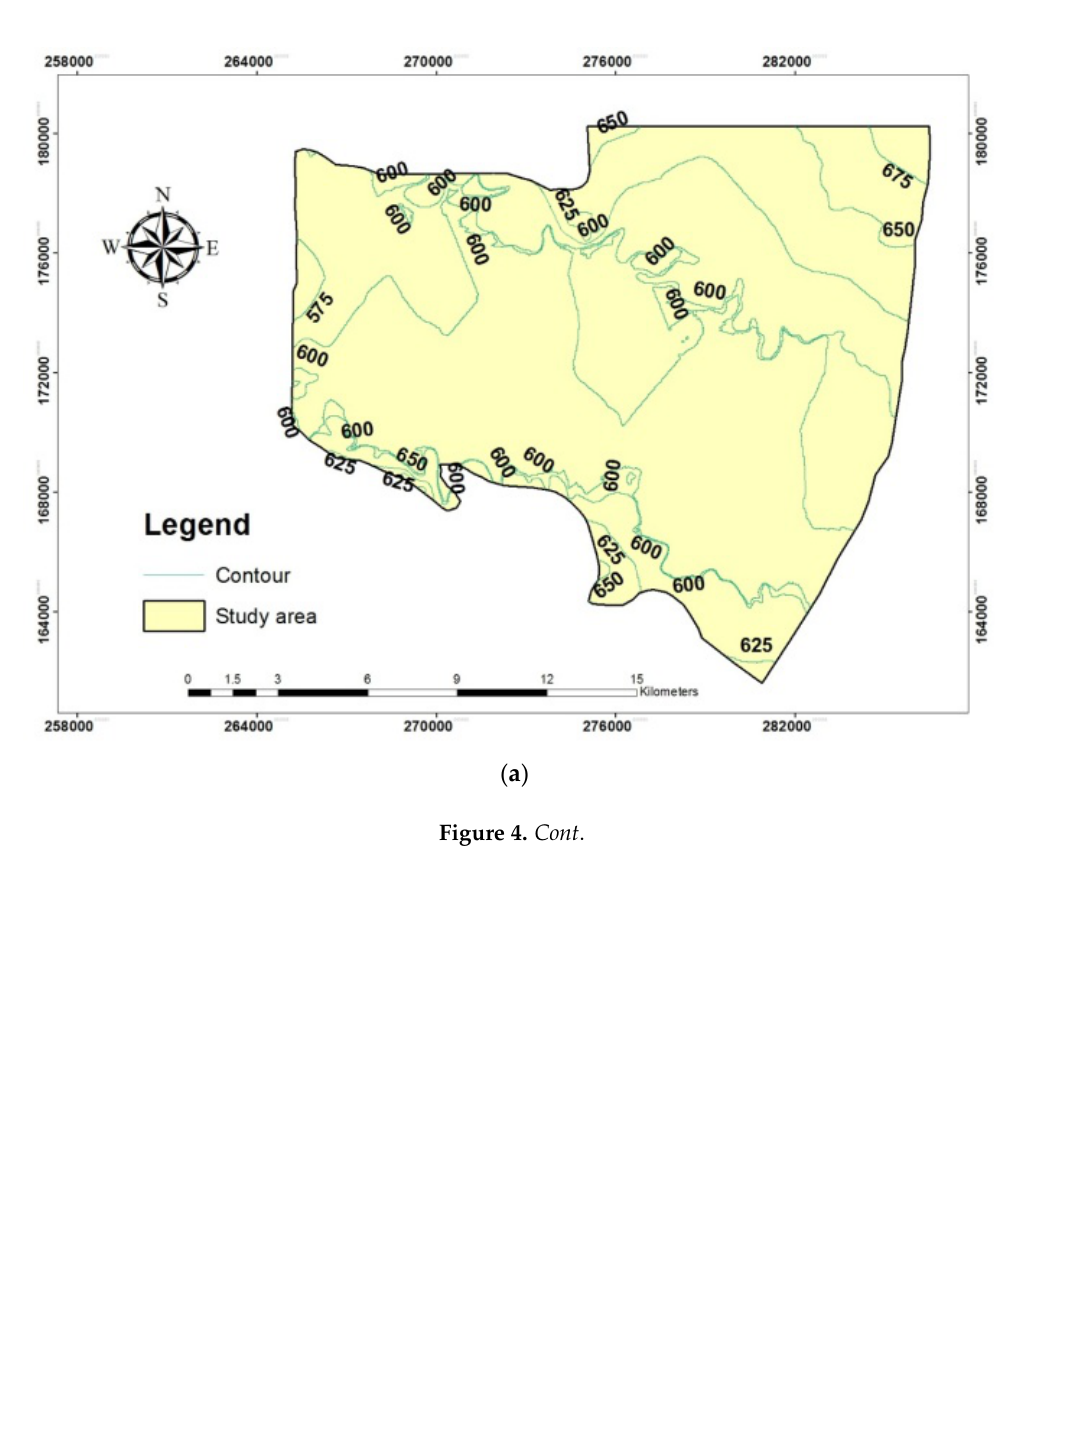
Figure 3. Conceptual model of the study